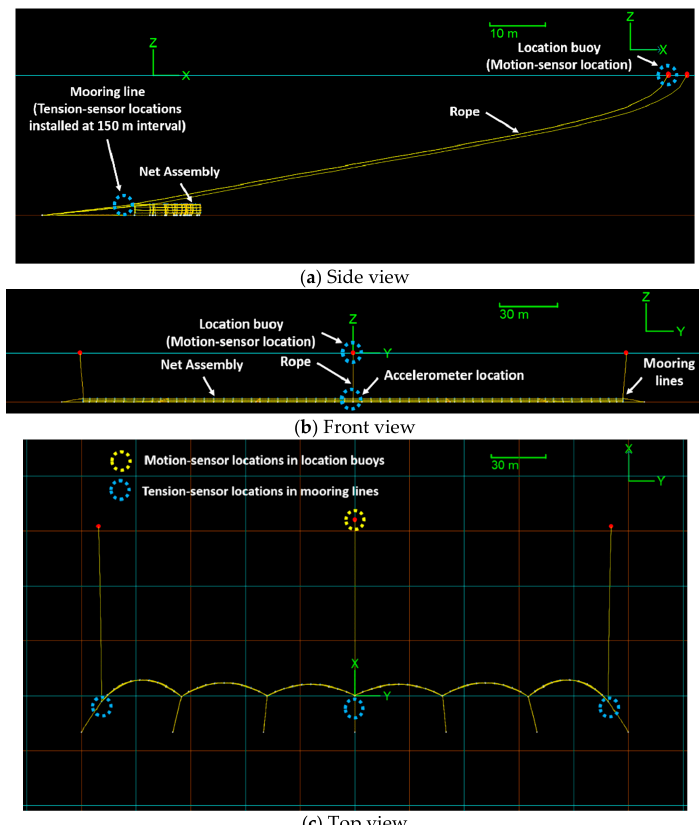
Figure 2. Side ( a ), front ( b ), and top ( c ) views of the designed numerical model of the bottom-set gillnet.